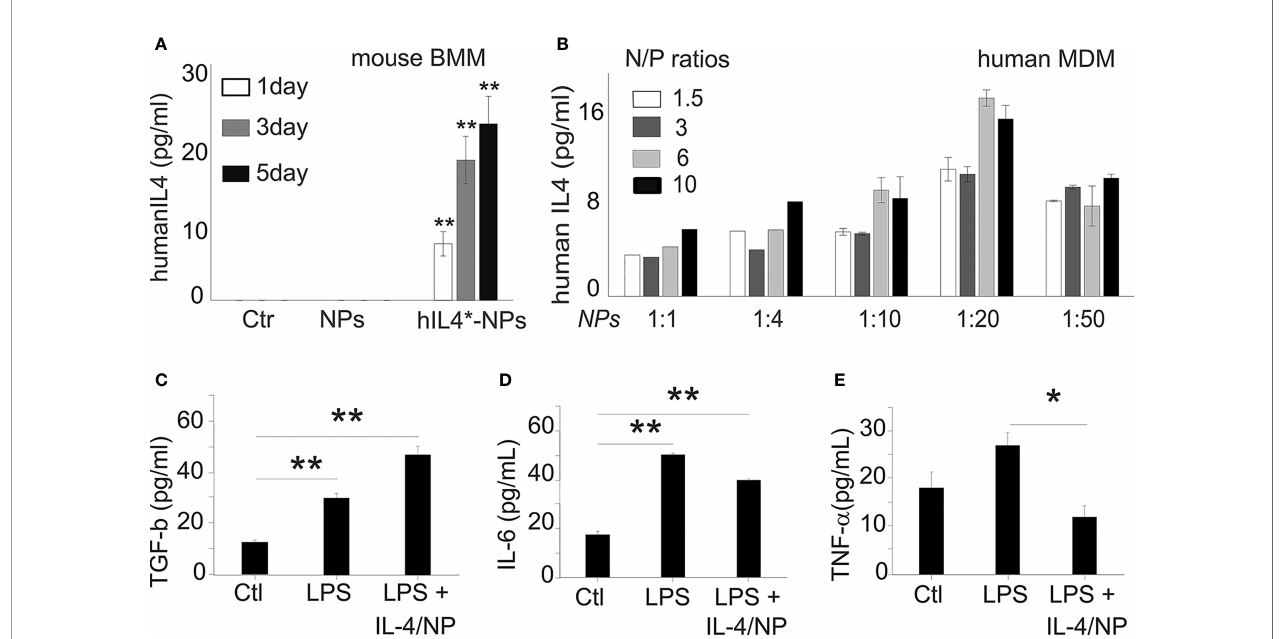
FIGURE 7 | Exogenous IL-4 production induces MDM responses. (A) Mouse bone marrow derived macrophages (BMM) were used to determine human IL-4pDNA transfection and production. An ELISA assay with human speci fi c antibodies showed human IL-4 secretion from mouse BMM transfected with IL-4pDNA-NPs. The human IL-4 expression in mouse BMM were increased from day 1 to day 5 (** p< 0.01 hIL4-NPs v.s Ctr and NPs). No human IL-4 was detected in mouse BMM in normal and NPs control groups. These results indicate the successful expression of exogenous IL-4 production in macrophages. (B) The secretion of IL-4 from MDM was quanti fi ed with different IL-4pDNA-NP concentrations at various NP/media ratios. IL-4 protein was detected in the media for all conditions, while the highest expression was obtained in MDM treated with IL-4pDNA-NPs at N/P ratios of 6 and under, and a NPs to media volume ratio at 1:20. Exogenous IL-4 was produced from IL-4pDNA-NP transfected MDM. Polarizing M1 macrophages into M2 by exogenous IL-4 was then investigated in LPS induced in fl ammatory M1 MDM with IL- 4pDNA-NPs (LPS+IL4/NPs). Untreated MDM (Ctr) and LPS alone (LPS) served as the controls. ELISA was used to detect the levels of TGF- b , IL-6 and TNF- a . (C) TGF- b , an anti-in fl ammatory cytokine and a marker of M2 macrophages, is signi fi cantly increased in IL-4pDNA-NP treated cultures compared to MDM and LPS- in fl ammatory MDM (* p < 0.01). In fl ammatory M1 markers of IL-6 (D) and TNF- a (E) were increased in LPS-in fl ammatory MDM. However, IL-4pDNA-NPs treatment decreased the secretion of IL-6 and TNF- a (* p < 0.01). MDM responded to the production of exogenous IL-4 and polarized M1 into M2. Signi fi cance was evaluated with a one-way ANOVA followed by Tukey ’ s post-hoc analysis. Error bars represent s.e.m. * p < 0.05, ** p <